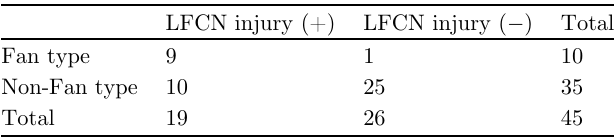
Table 1. Result of preoperative ultrasound and survey of self reported questionnaire of LFCN injury.